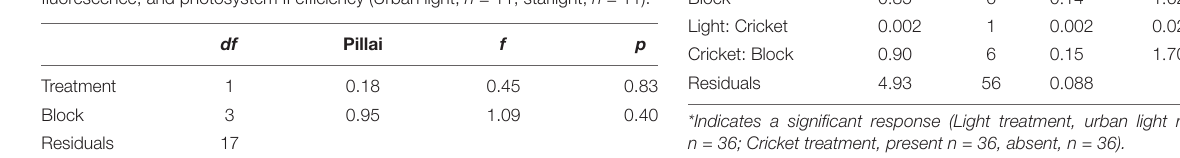
TABLE 1 | MANOVA table of the gas exchange results evaluating differences in photosynthesis, stomatal conductance in dark, stomatal conductance in light,